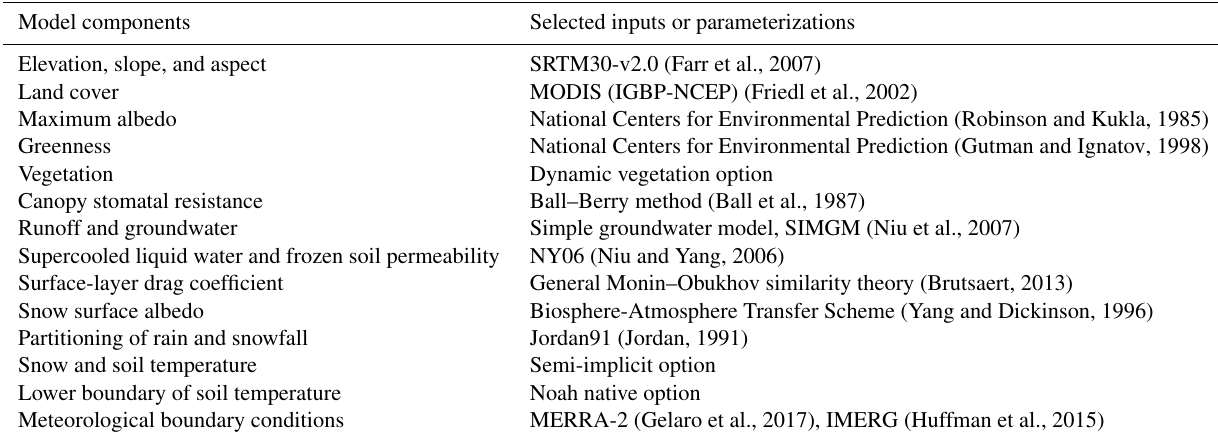
Table 1. Selection of model components in Noah-MP version 4.0.1 as implemented within LIS (Sect.